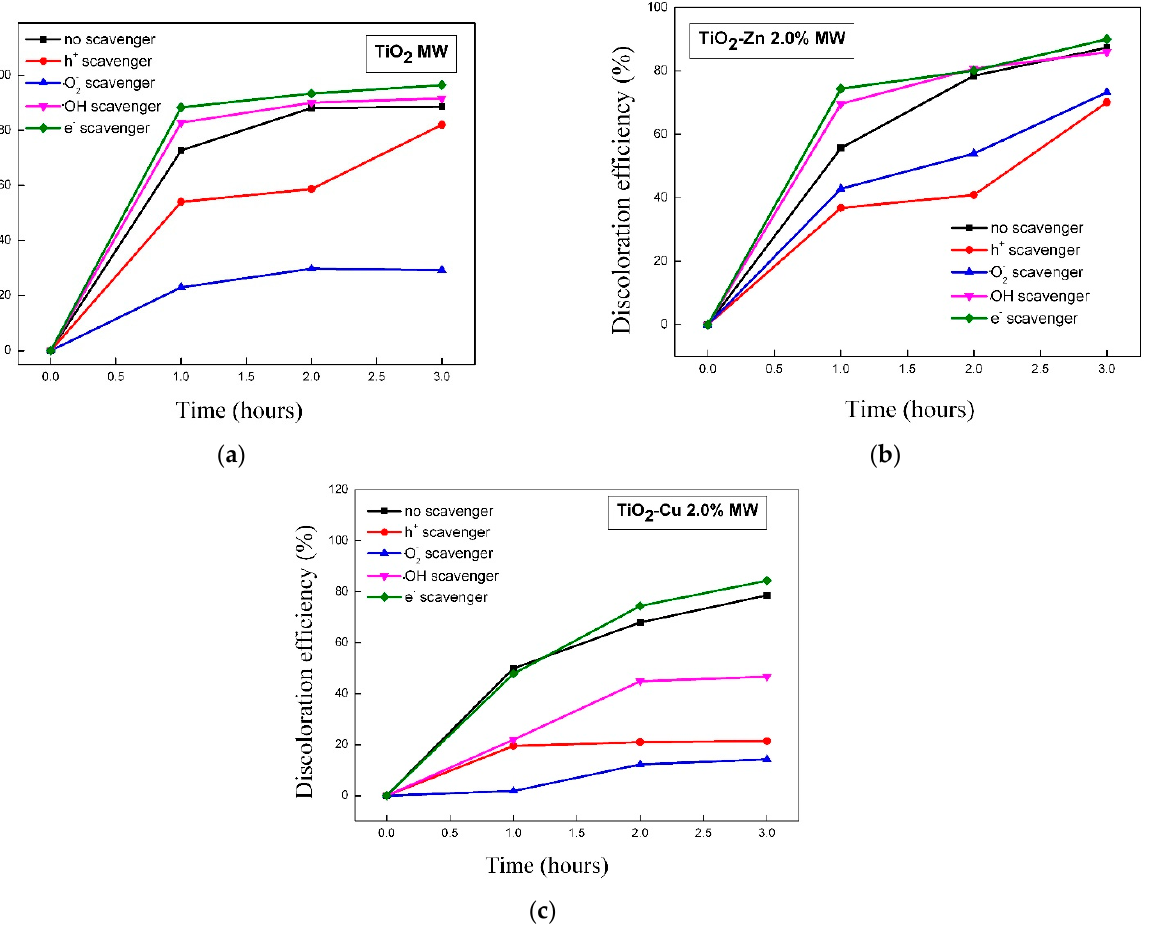
Figure 18. The e ff ect of scavengers on the photocatalytic degradation of methyl orange under UV- Figure 18. The effect of scavengers on the photocatalytic degradation of methyl orange under UV-light light irradiation for ( a ) TiO 2 MW, ( b ) TiO 2 -Zn MW, and ( c ) TiO 2 − Cu MW samples. irradiation for ( a ) TiO 2 MW, ( b ) TiO 2 -Zn MW, and ( c ) TiO 2 − Cu MW